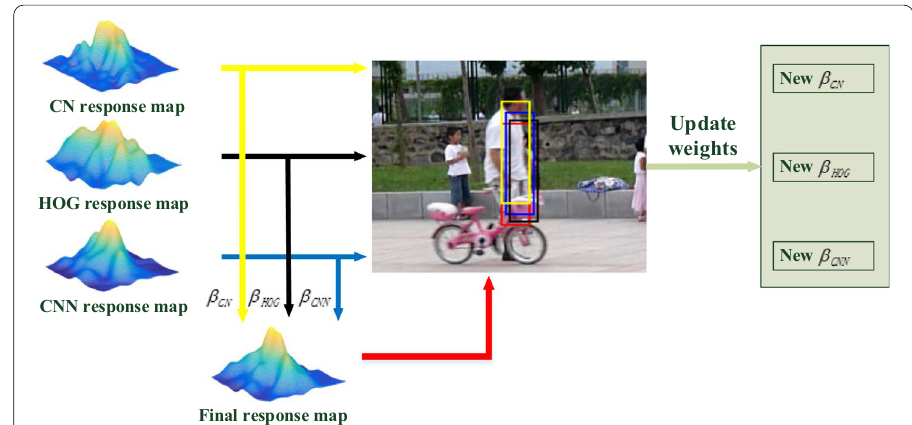
Fig. 2 Feature response map fusion and weight